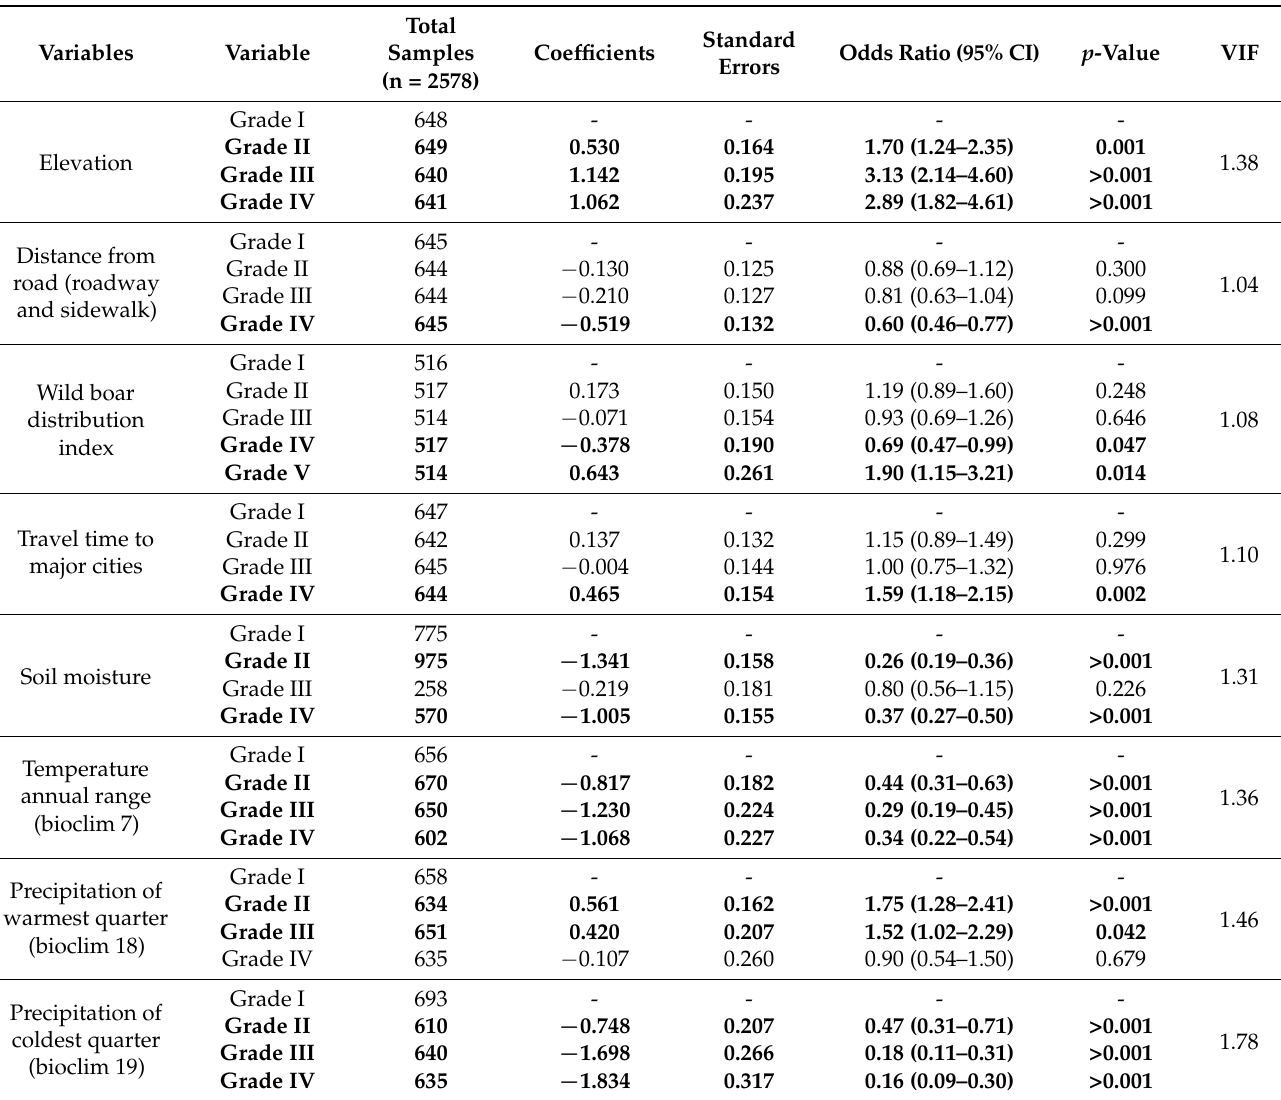
Table 3. Results of the Generalized linear logistic regression analysis. Variables with p -values less than 0.05 are shown in